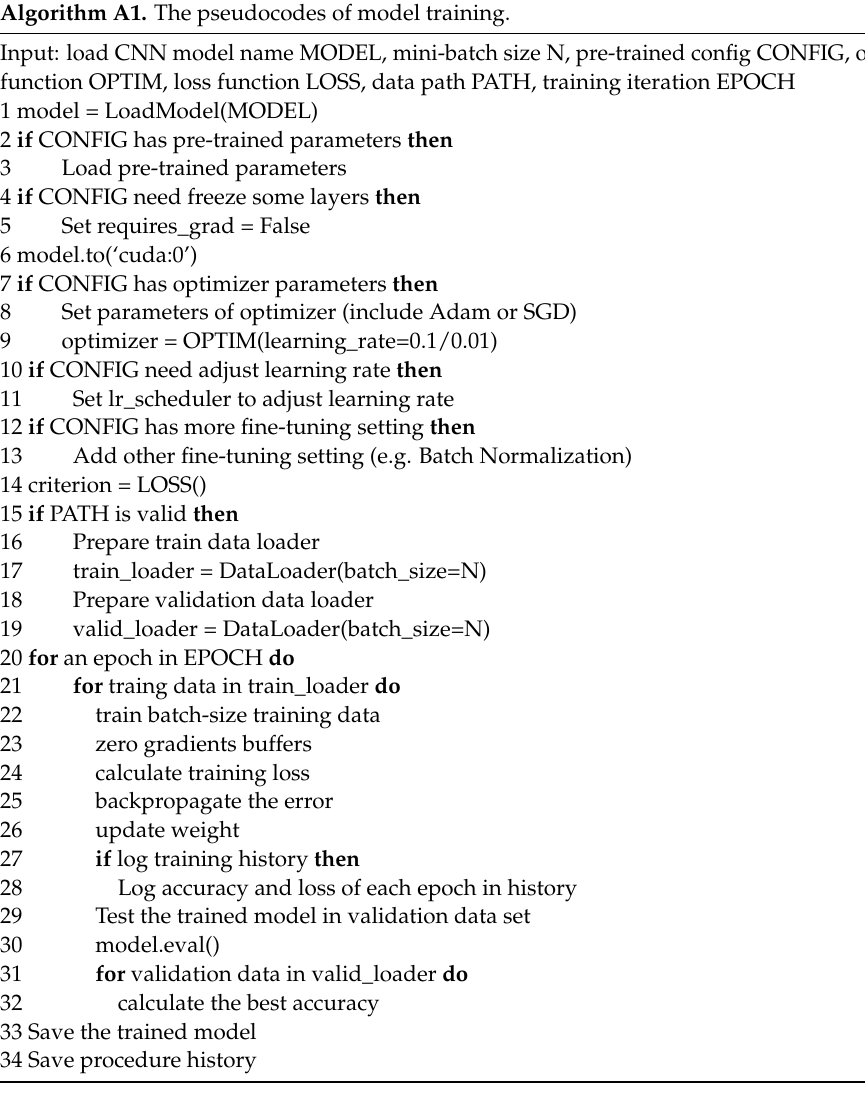
Algorithm A1. The pseudocodes of model